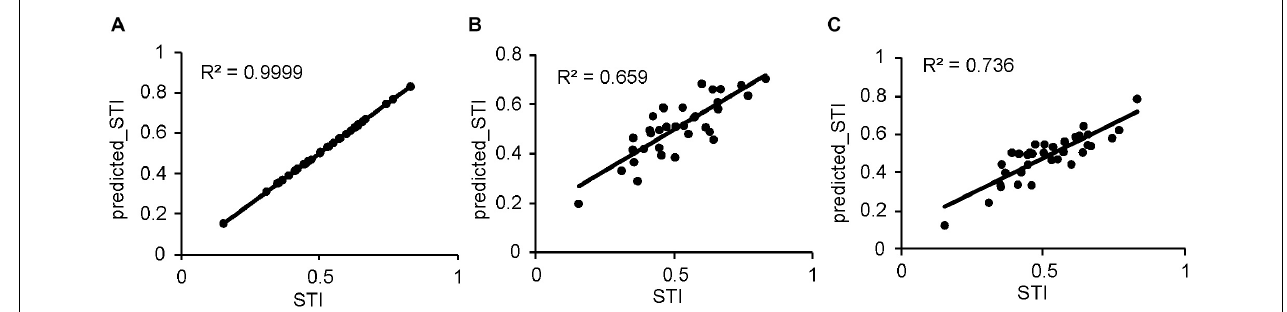
FIGURE 5 | Correlations between actual STI and the STI predicted from the agro-physiological traits with significant contributions to salinity tolerance ( Table 4 ). (A) Trait ratios. (B) Traits under salt stress. (C) Traits under the control condition.